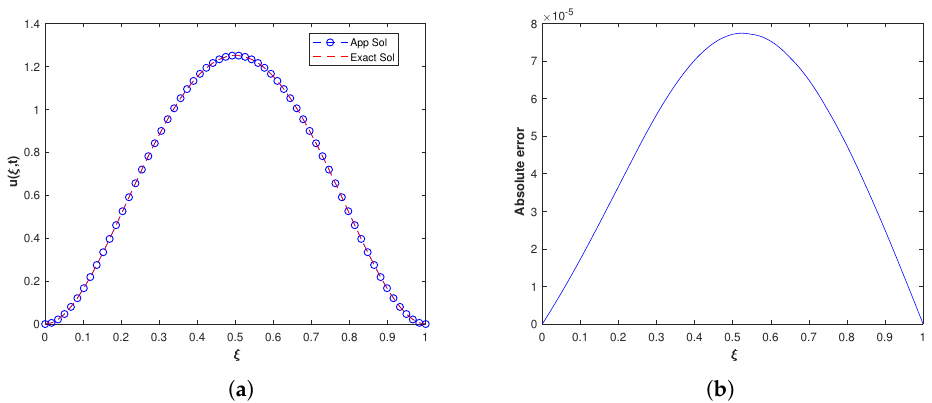
Figure 6. ( a ) Plot of approximate solution and exact solutions of Problem 2 with α = 0.8. It is seen that the numerical solution agrees well with the exact solution. ( b ) Plot of absolute error of Problem 2 with α = 0.8, N = 295, n = 5, M = 28 at t = 1.